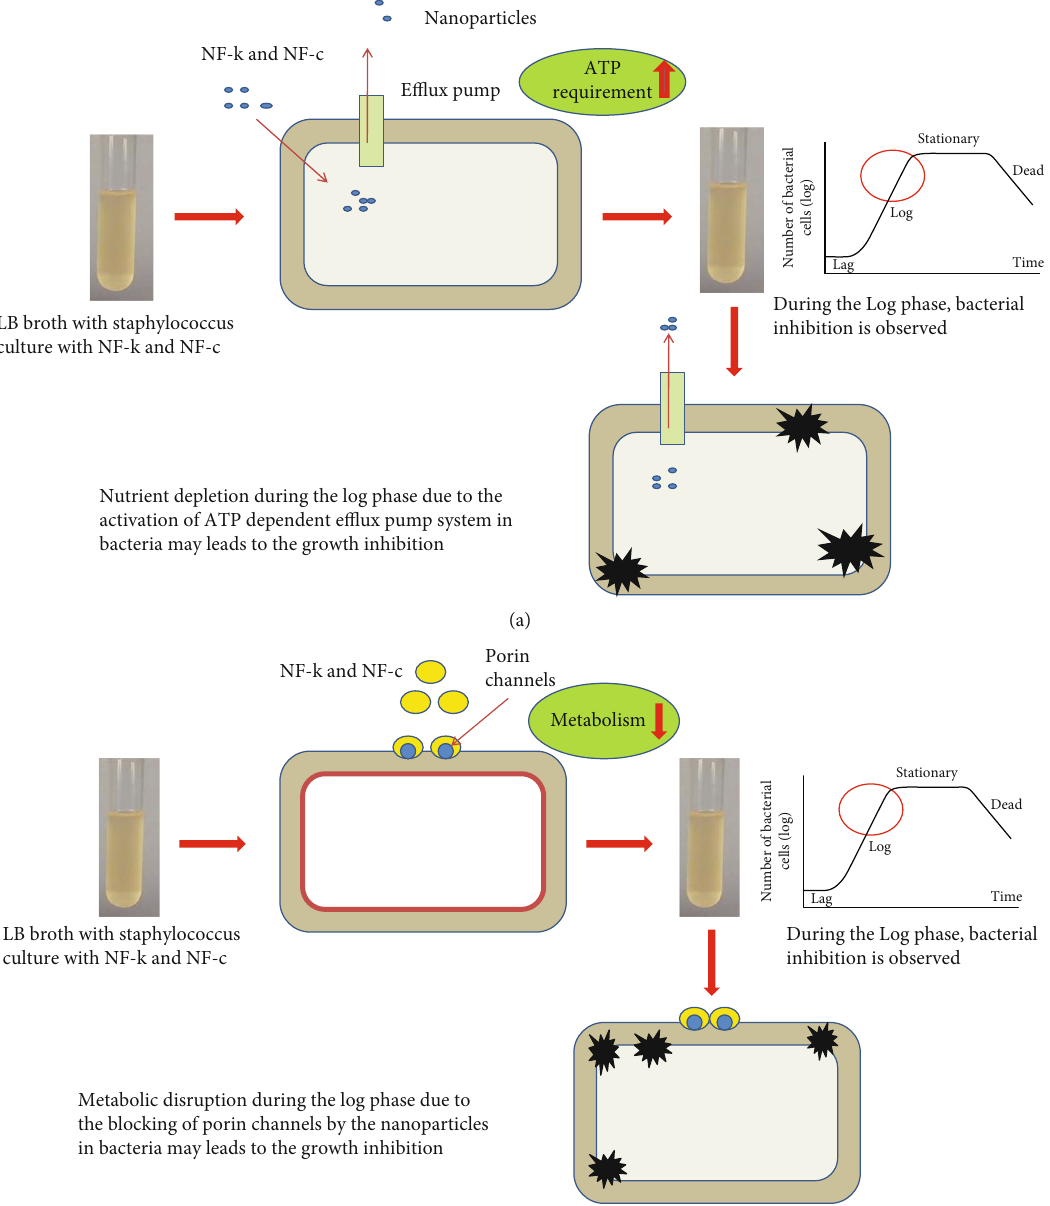
Figure 10: Possible mechanisms of antibacterial activity of nanoformulated drug through (a) blocking of porin channels and (b) activation of ATP-dependent e ffl ux pump